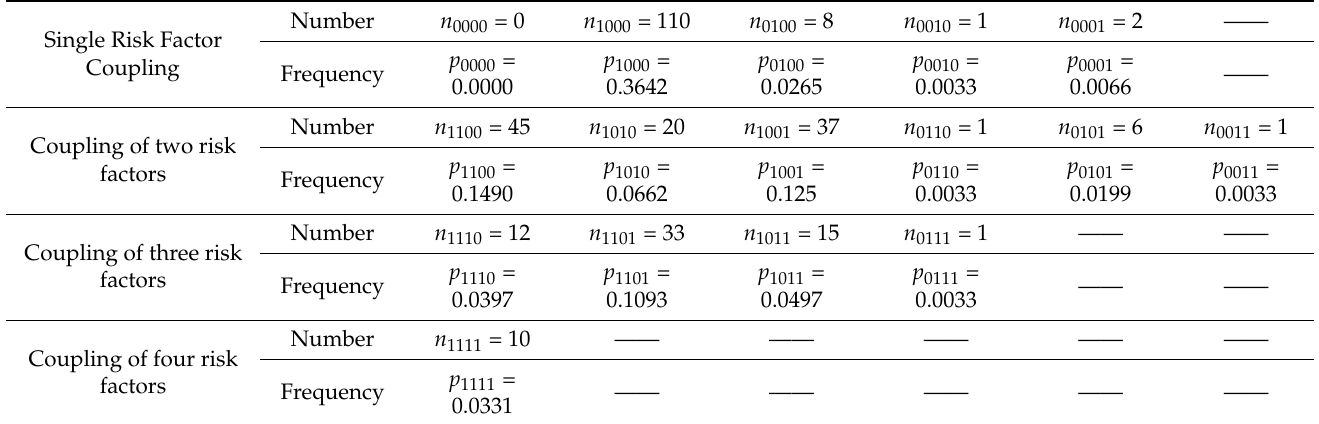
Table 4. Number and frequency of risk coupling of inland river accidents.